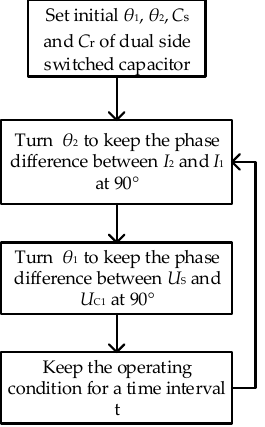
Figure 10. Flowchart of the control strategy.